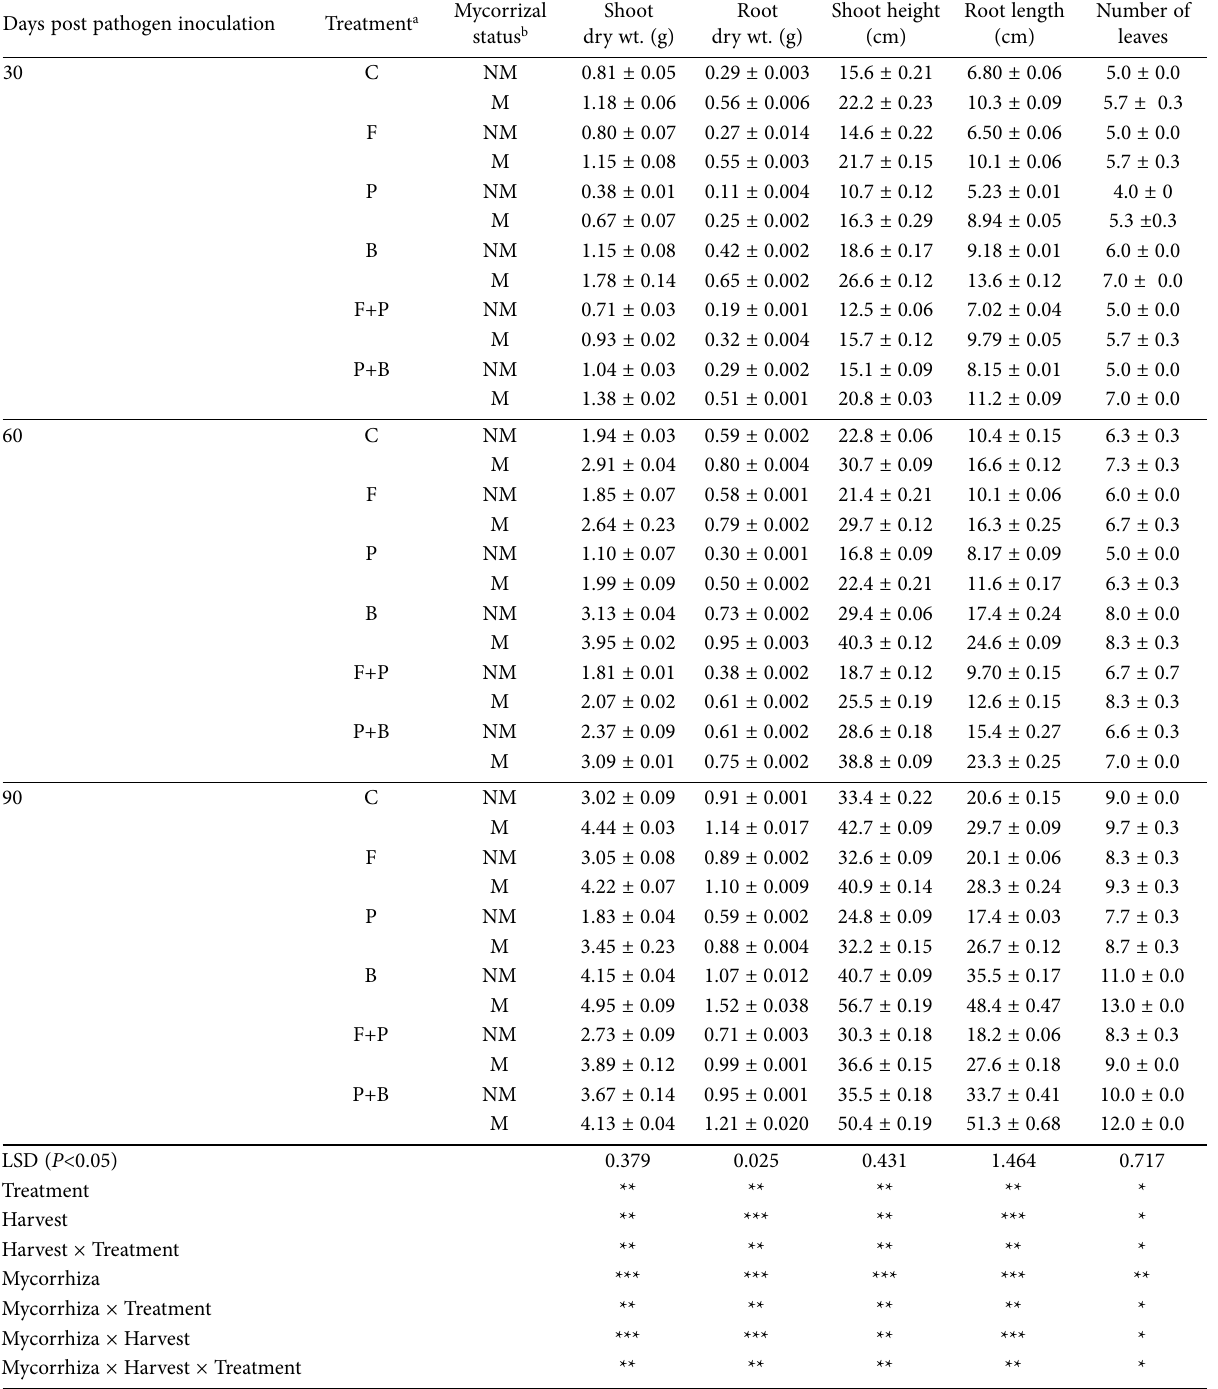
Table 2. Mean garlic plant growth parameters (± standard error) for plants inoculated with Sclerotium cepivorum and treated with AMF and/or Bacillus amyloliquefaciens